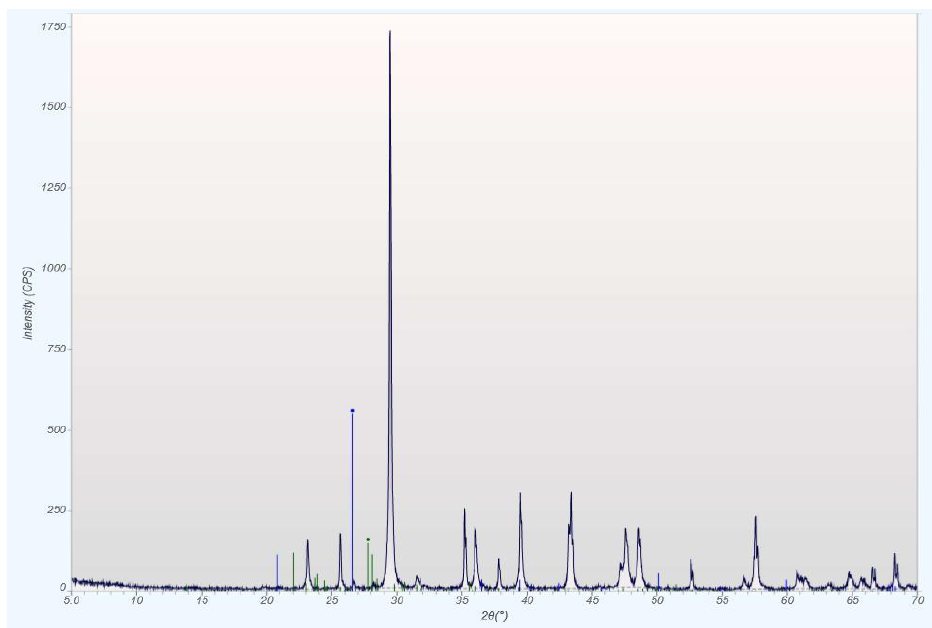
Figure D2: qXRD spectra for the oolitic chalk sample CK-6.